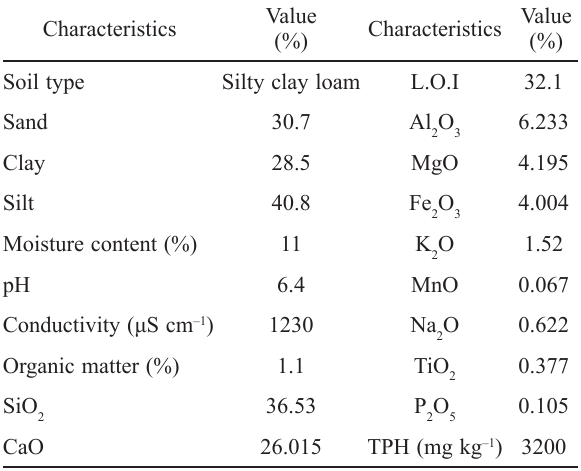
Table 1 – Characteristics of oily sludge contaminated soil Characteristics